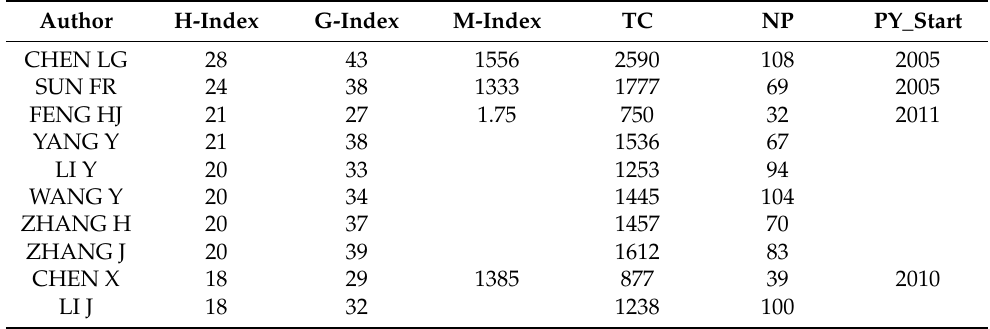
Table 3. H-Index top ten